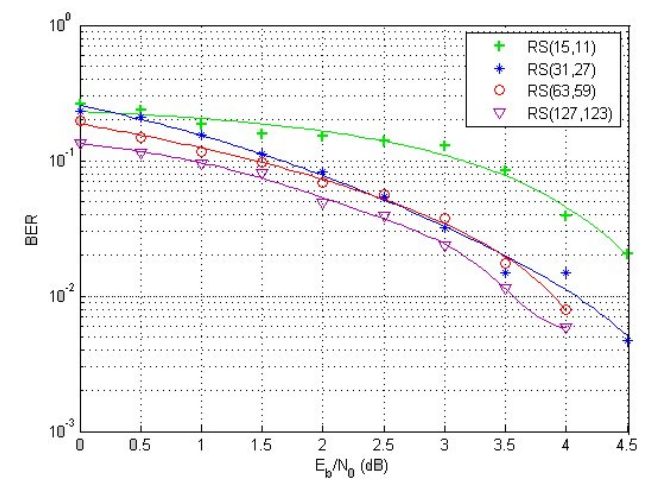
Figure 7. Performance of the Reed–Solomon code for similar error correction.